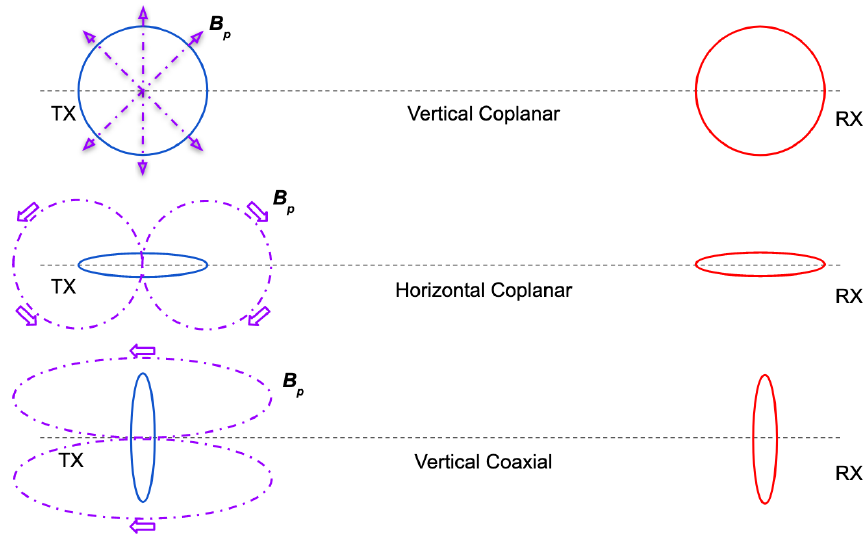
Figure 2. Fully coupled orientations for coplanar and coaxial T x and R x loops. The purple lines and arrows represent the magnetic field generated by the T x antenna. Top: vertical coplanar. Middle: horizontal coplanar. Bottom: vertical coaxial.